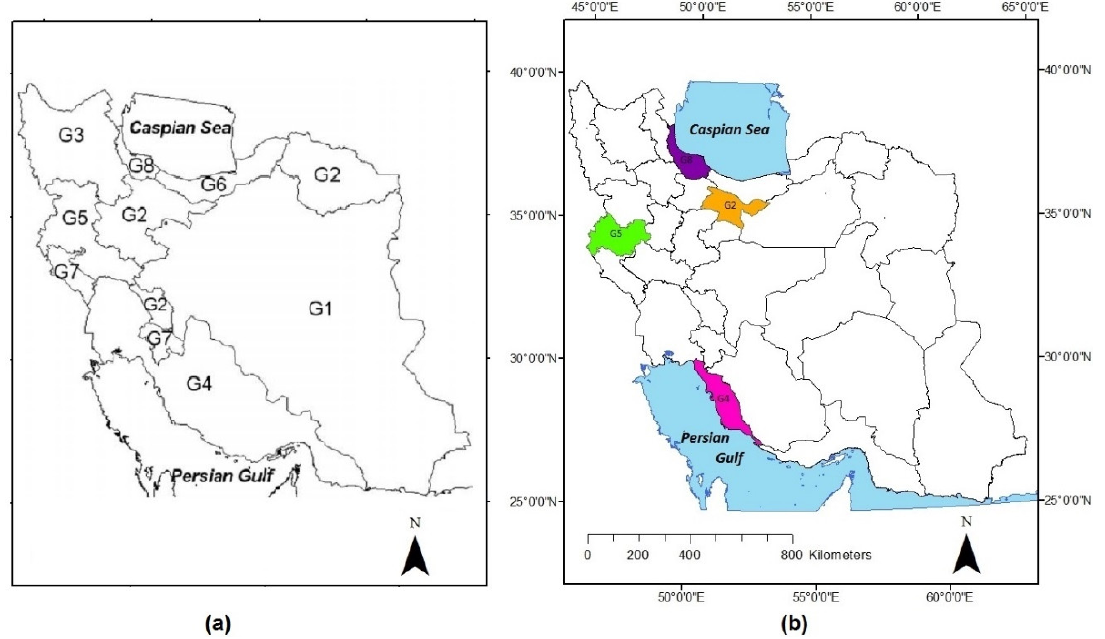
Figure 1. ( a ) Spatial distribution of precipitation zones of Iran [31]; and ( b ) Provincial map of Iran and the four selected study regions.